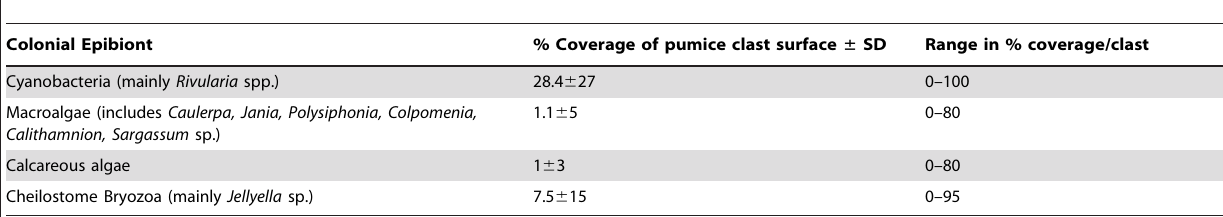
Table 3. Quantitative data for colonial epibionts transported by the 2006–2007 pumice rafts.